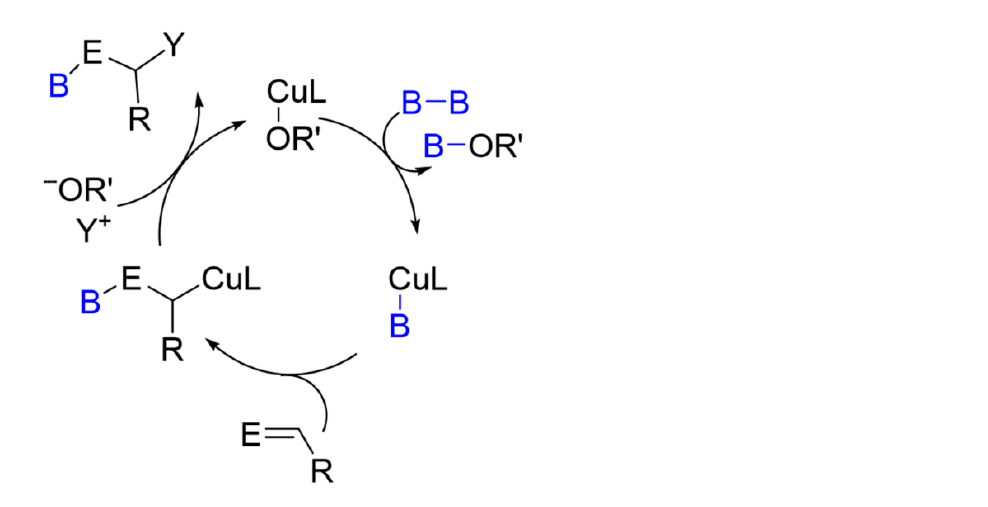
Scheme 1. The general mechanism for copper-boryl-mediated reaction with an unsaturated mole- cule.